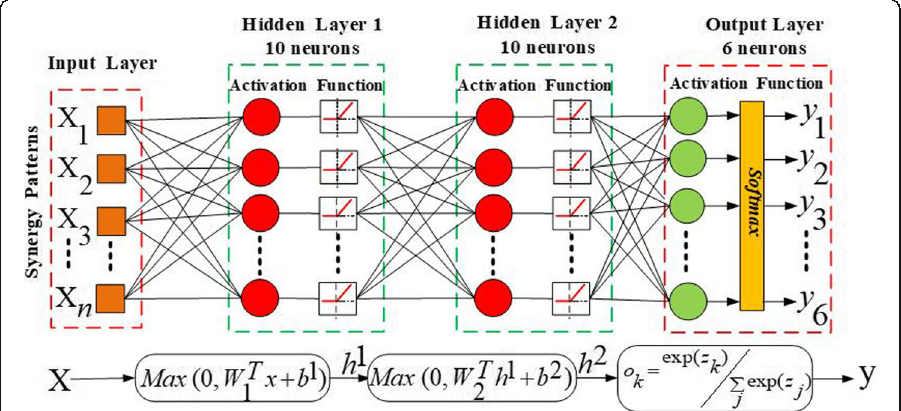
Fig. 3 Structure of the used MLP artificial neural network with two hidden layers. Where x and y are the input and the output. h i is i th hidden layer and b i is a bias term. W i are the parameters of the i th layer